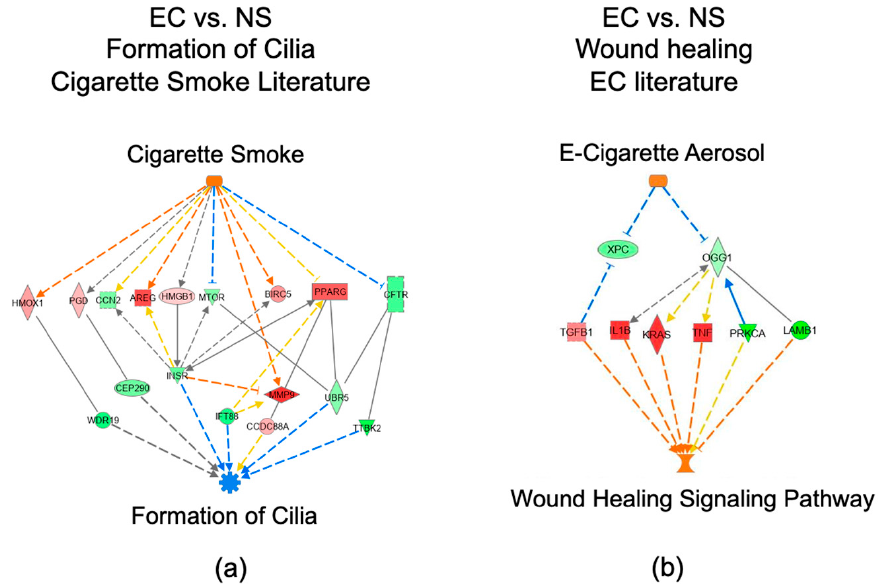
Figure 5. Pathways involved in formation of cilia and wound healing in our EC vs. NS set identified using IPA. ( a ) “Formation of Cilia” generated by overlaying our data on the cigarette smoke literature. ( b ) “Wound Healing Signaling Pathway” generated by overlaying our data on the EC literature. Upregulated DEGs are pink-to-red depending on fold-change, whereas green DEGs indicate downregulation. Orange arrows represent predicted activation, yellow arrows indicate non-consistent activation, and grey arrows represent effect not predicted.